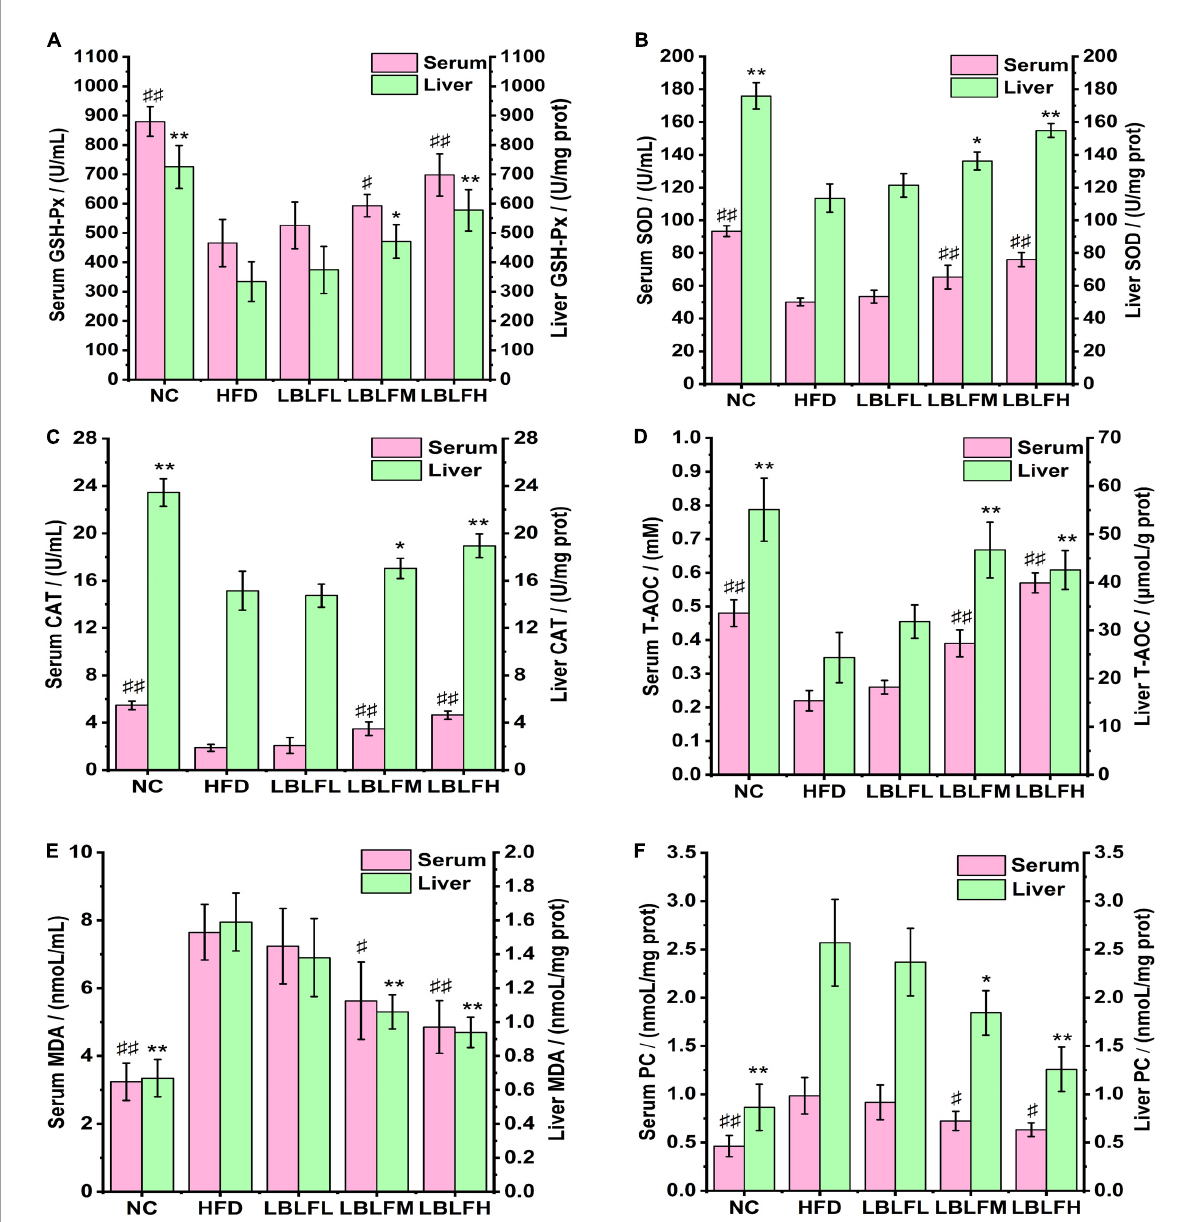
FIGURE4 Effects of LBLF supplement on markers of oxidative stress, including (A) GSH-P x , (B) SOD, (C) CAT, (D) T-AOC, (E) MDA, and (F) PC, in serum and liver. Serum markers: ( # p < 0.05) and ( ## p <0.01) vs. HFD group. Liver markers: (* p < 0.05) and (** p < 0.01) vs. HFD